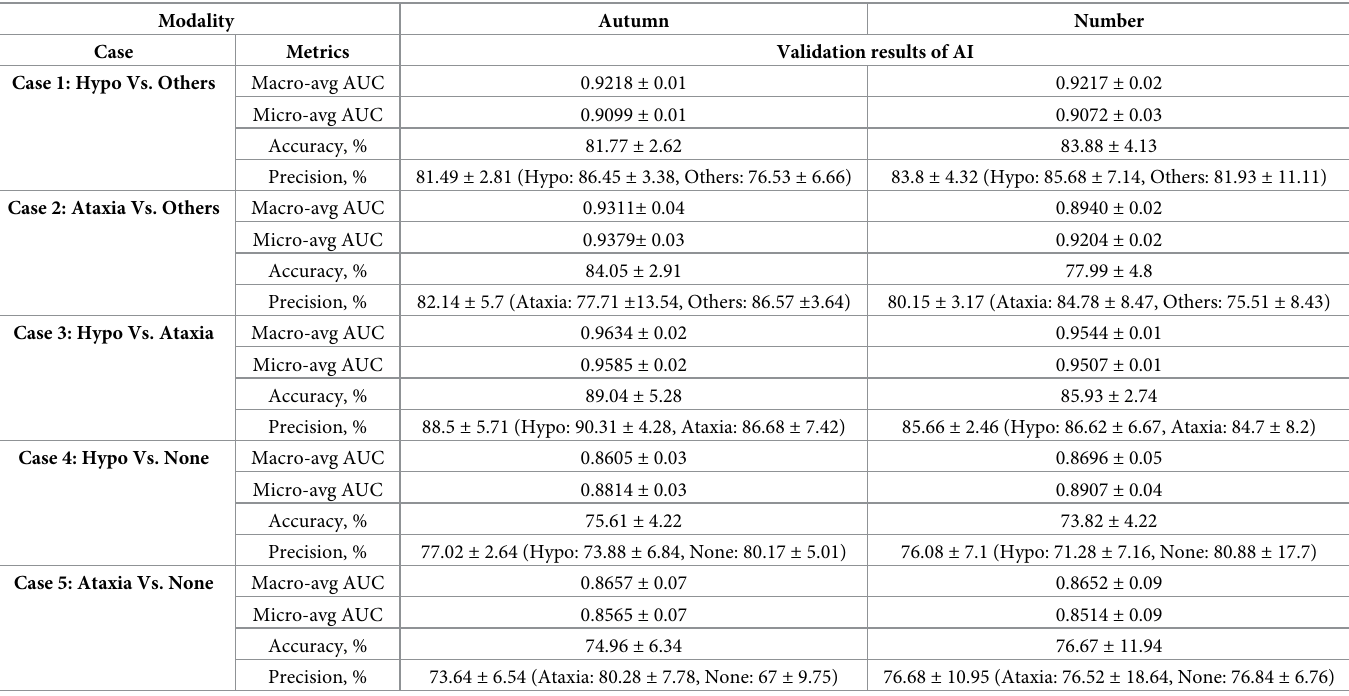
Table 4. AUCs, accuracy, and precision for the proposed PWSI-AI.